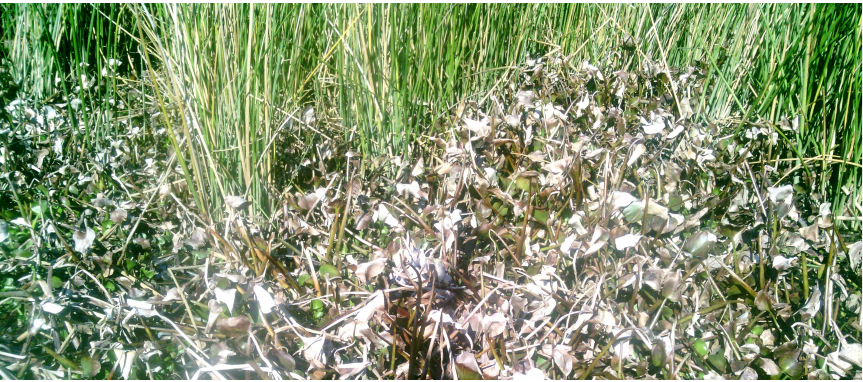
Figure 9. Field photo of water hyacinth in the UAV study region, showing its proximity to emergent and NPV which make detection